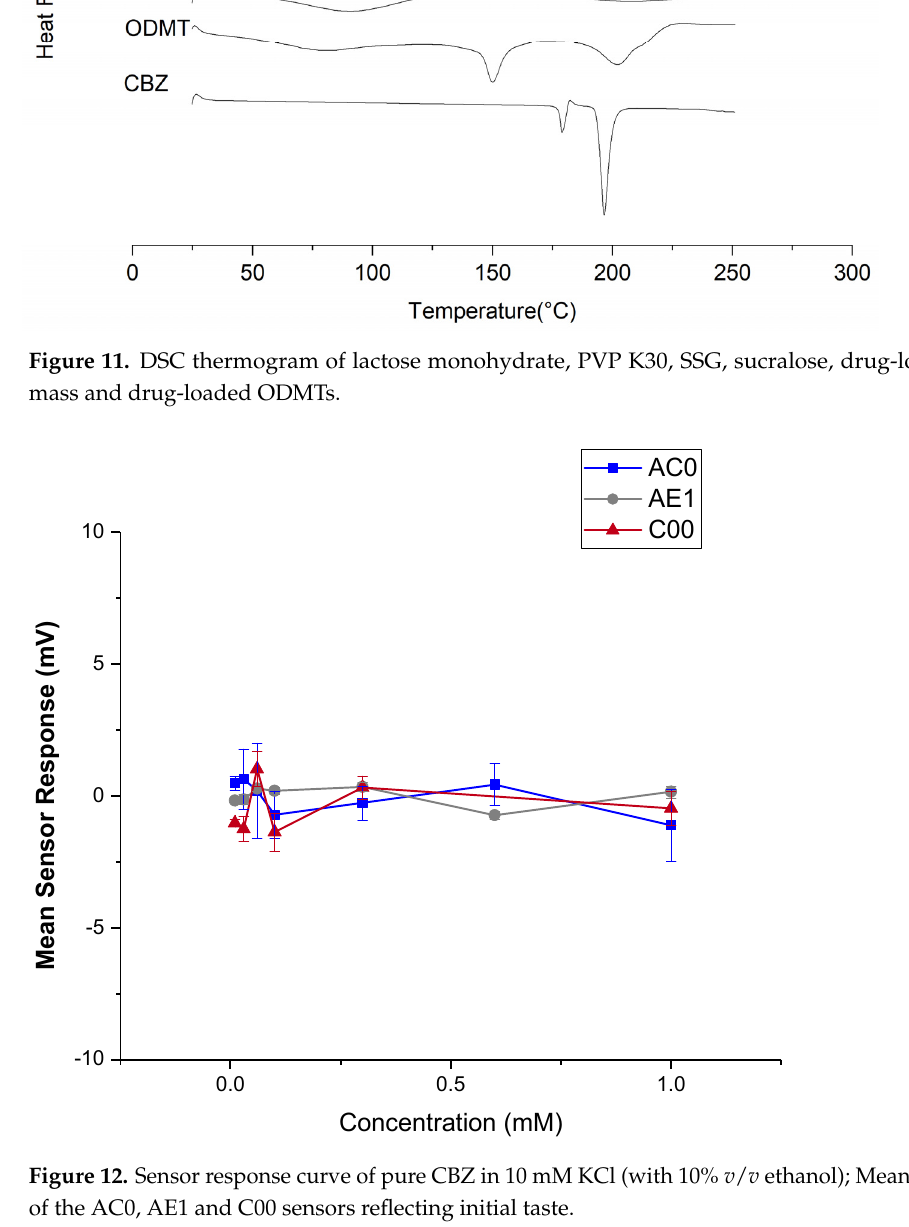
Figure 13. Sensor response curve of pure CBZ in 10 mM KCl (with 10% v / v ethanol); mean responses of the AC0, AE1 and C00 sensors reflecting aftertaste (CPA). It is worth noting that the concentration used for taste assessment here is relatively low, and a higher concentration could not be applied to the E-tongue due to the low solubility of CBZ (a solubility of 18 mg/L at 25 °C) [45]. The bitterness detected may therefore be problematic if the dosage is higher. This is especially evident if the dosing regimen requires multiple units or increased doses in a single unit, as bitterness may become more significant and taste masking approaches may need to be involved. Meanwhile, low ionisation of the drug could also be a limitation of the E-tongue